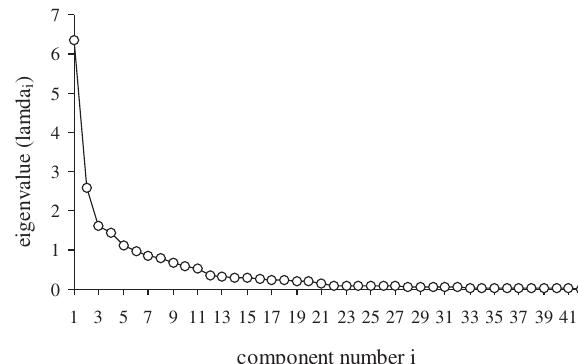
Fig . 3. – Scree diagram for the landings profile data matrix for boat seine fishing trips in the aegean